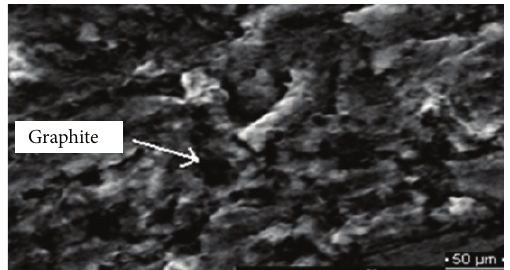
Figure 4: SEM micrograph of the Al-7.5wt.% Gr composite fab- ricated through two-stage stir casting followed by squeeze casting